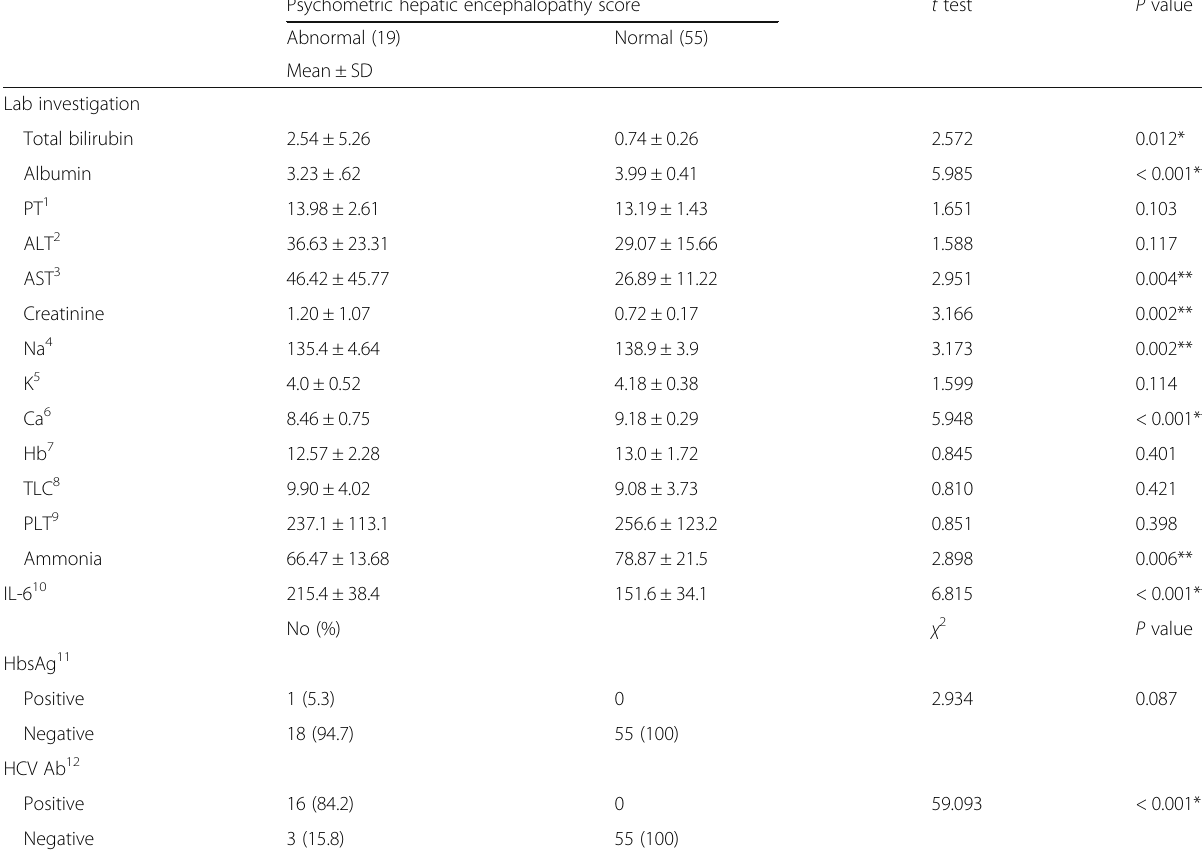
Table 2 Psychometric hepatic encephalopathy score and lab data Psychometric hepatic encephalopathy score t